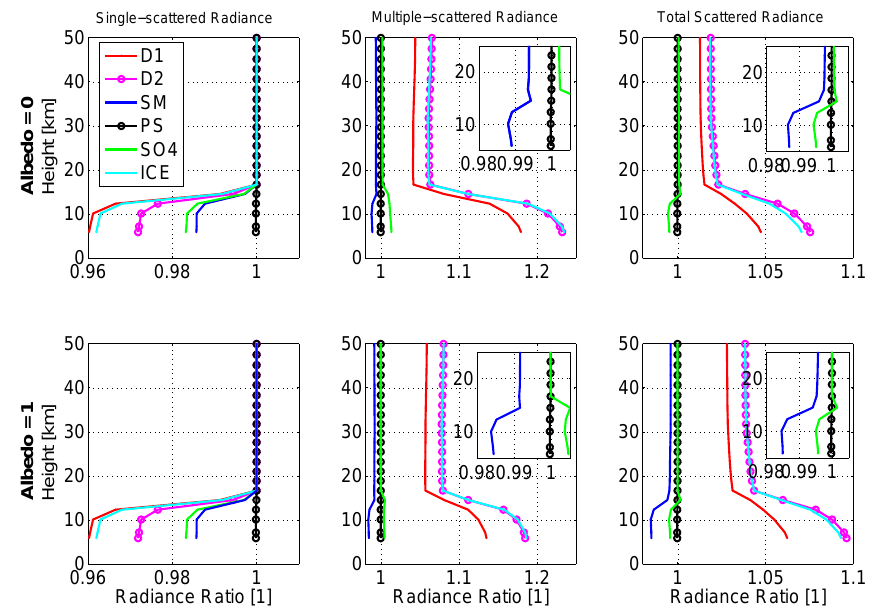
Fig. 8. As in Fig. 7 but at